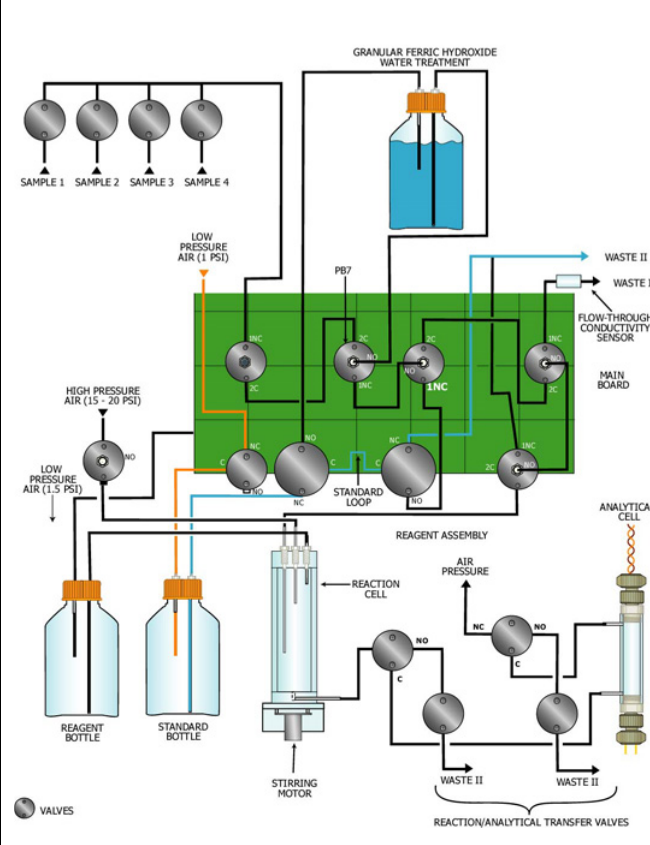
Figure 3. "Universal platform" with hexavalent chromium analytical system.